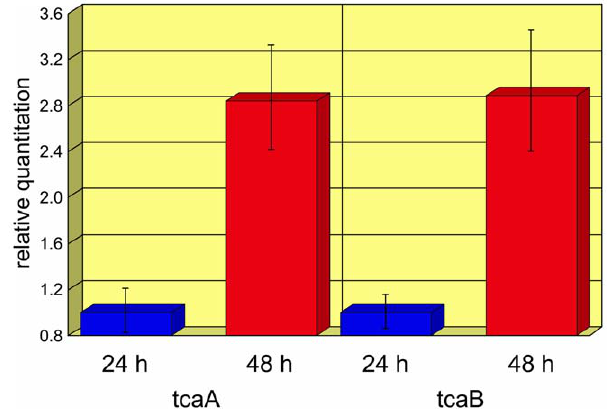
Figure 3. Relative expression of tcaA and tcaB by IBL 90 in infected gypsy moth larvae at 24 h and 48 h.